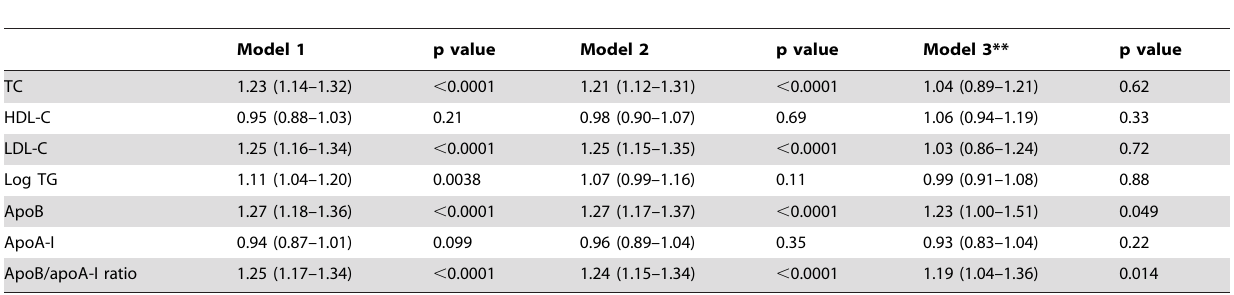
Table 3. Odds ratios per standard deviation increment of different lipids or lipid ratio with a 95% confidence interval for elevated CIMT.